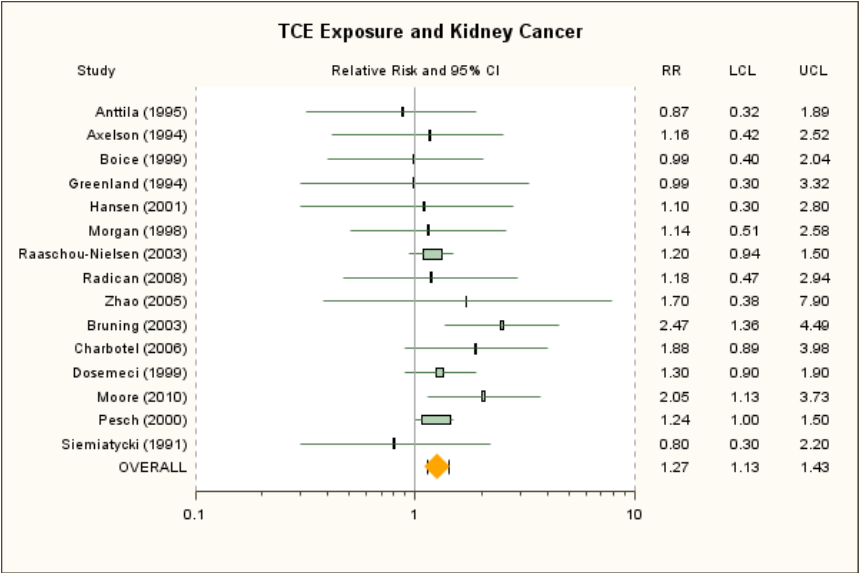
Figure 1. Forest plot of overall TCE exposure and kidney cancer from random-effects meta-analysis. Individual study results are plotted with 95% confidence intervals. Symbol sizes reflect relative weights of the 15 cohort and case-control studies.